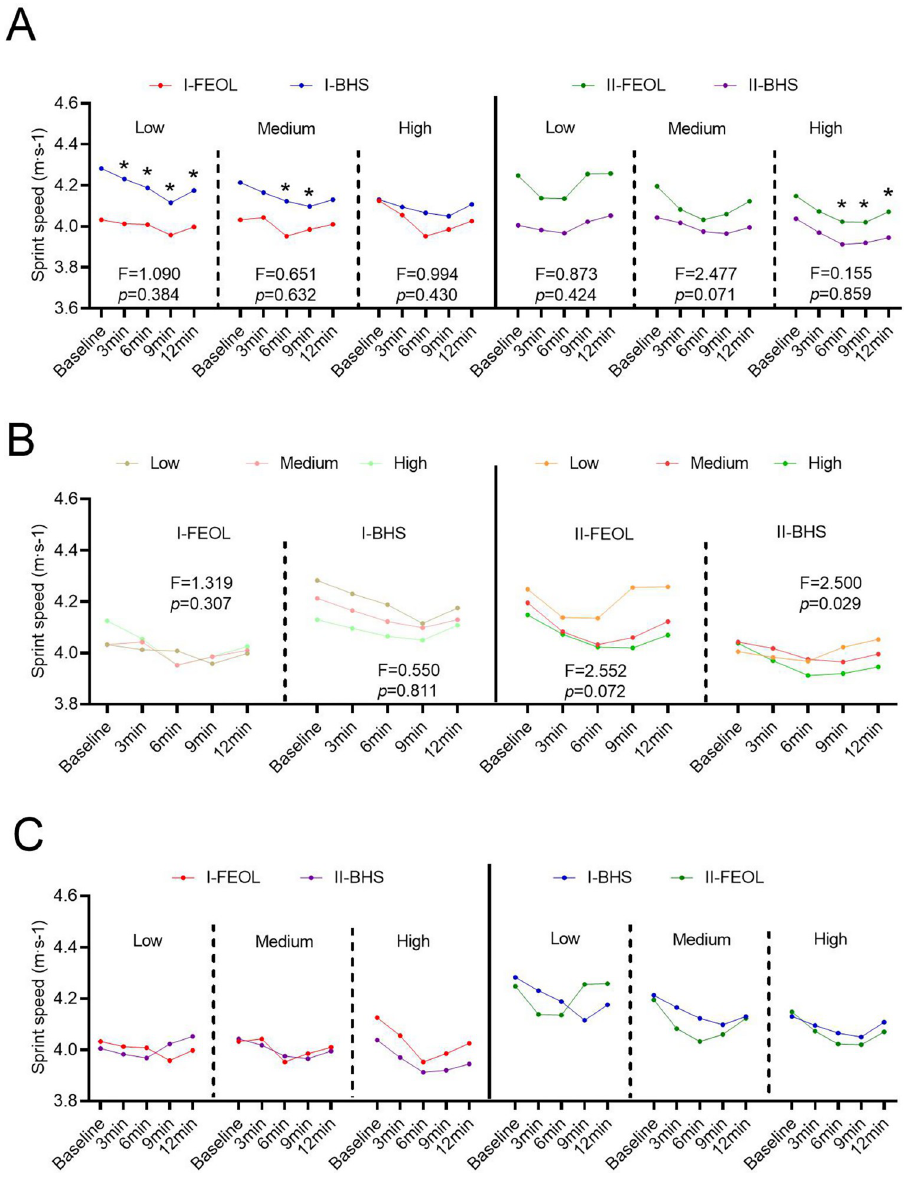
Fig 5. Effects of training intensity, interval time, and training method on the 30-meter sprint in two stages. (A) Time × protocol interaction effects on 30 m sprint speed over time in different training intensities. (B) Time × training intensity interaction effects on 30 m sprint speed over time with different training methods. (C) Comparison of 30 m sprint speeds of the same crowd under different training methods in the two